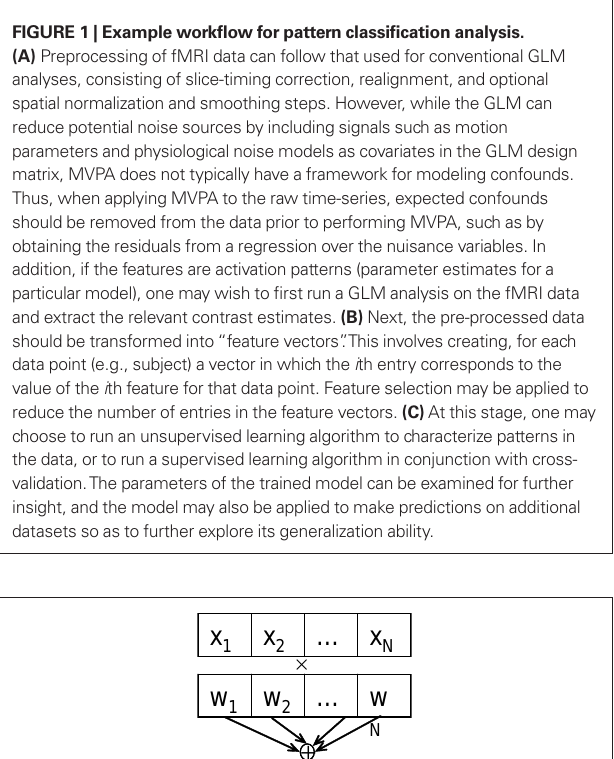
) of the data i ), and the summation i